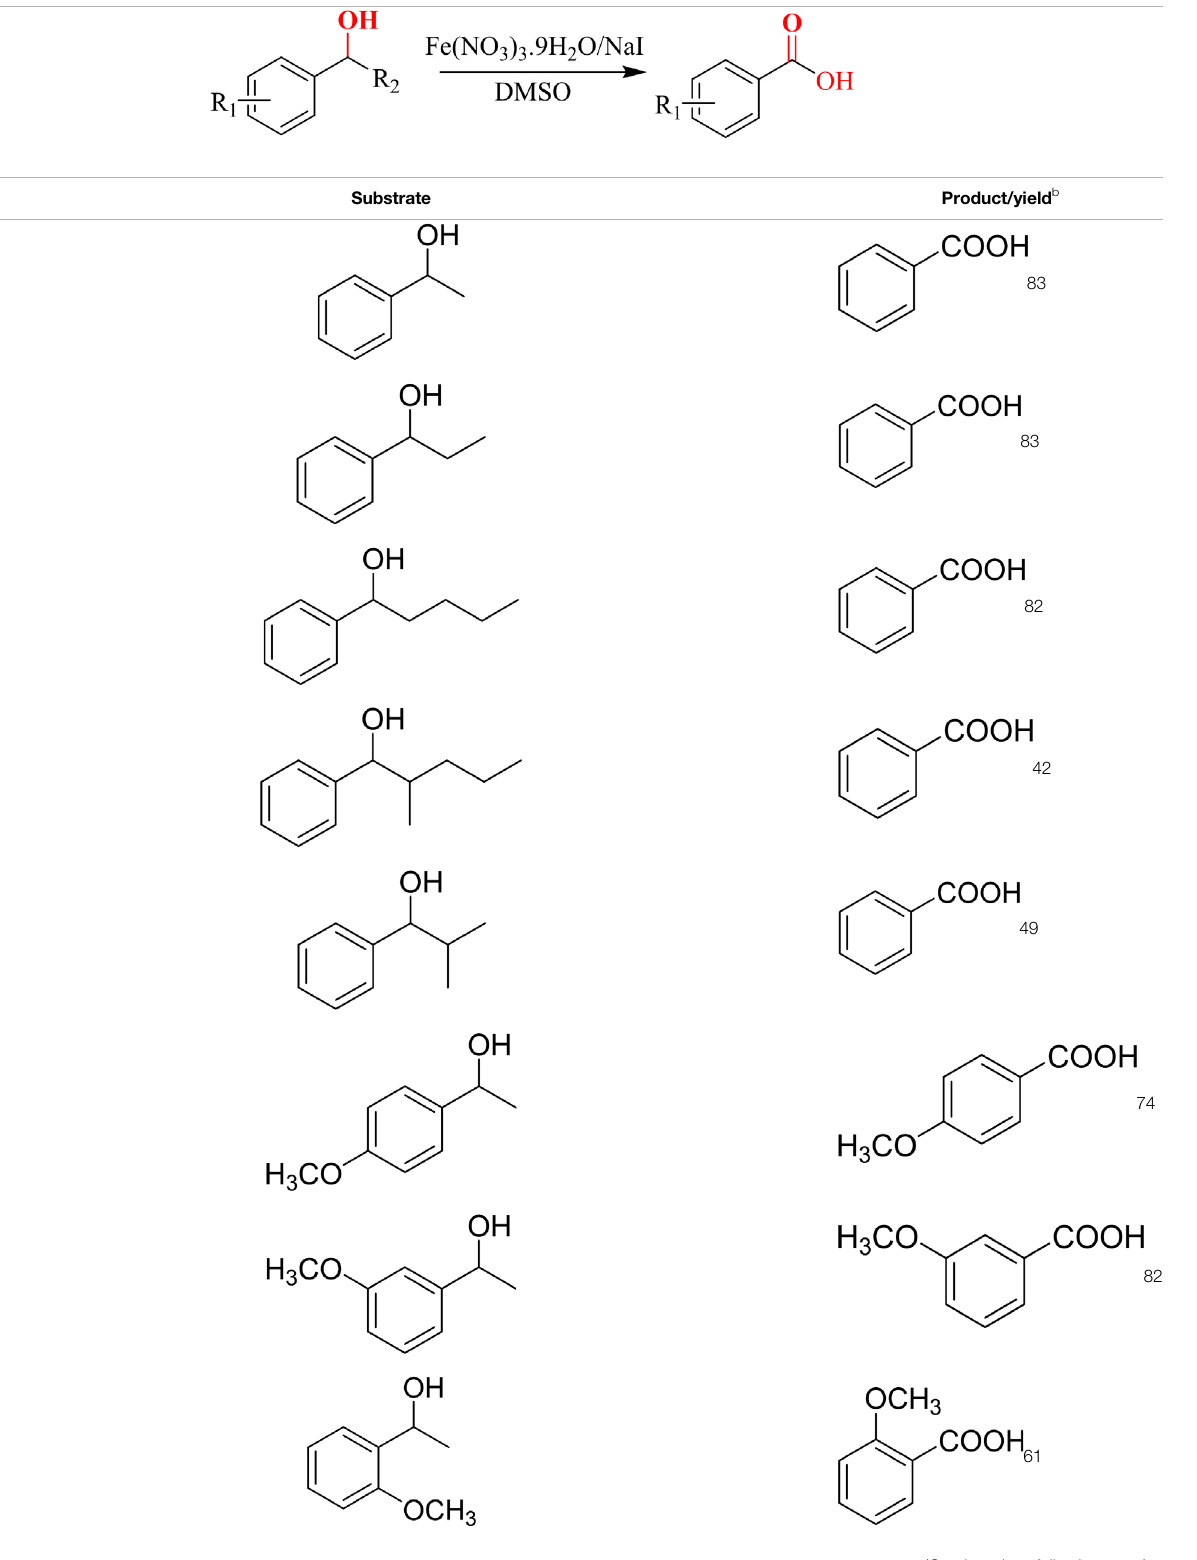
TABLE 2 | Catalytic aerobic oxidation of secondary alcohols a